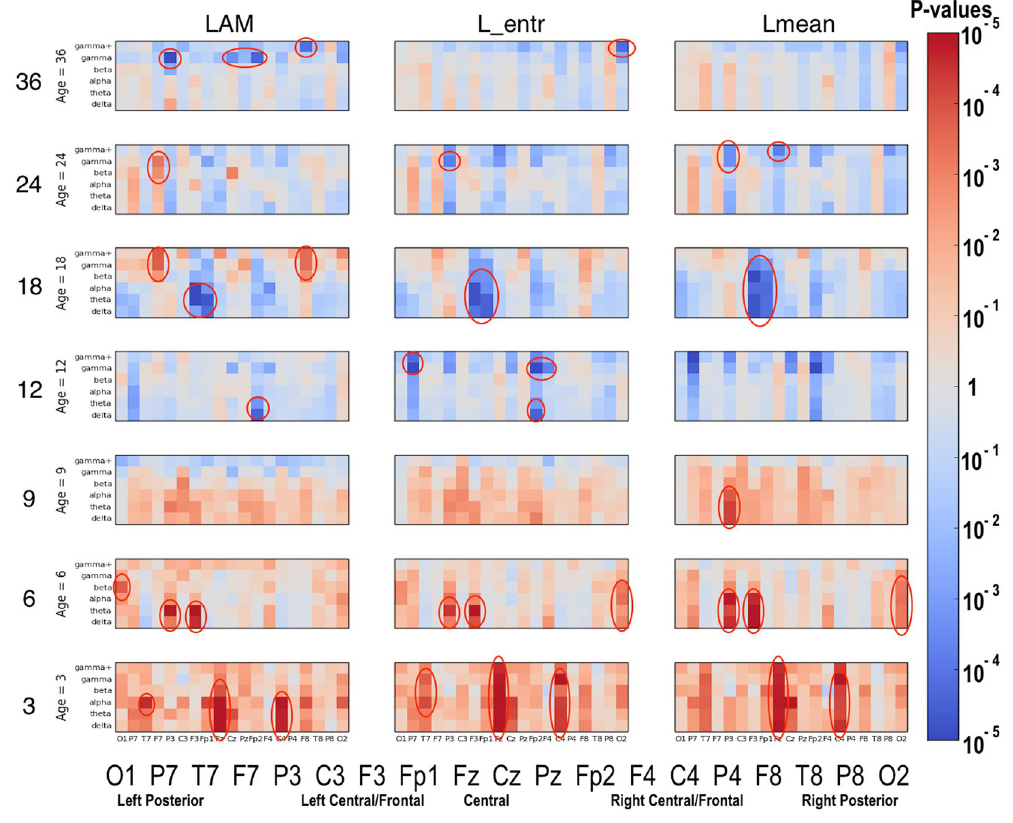
Figure 7. Similar to Fig. 5: differences between ASD and LRC − group values for LAM, L_mean, and L_entr are shown using color for every nonlinear value.